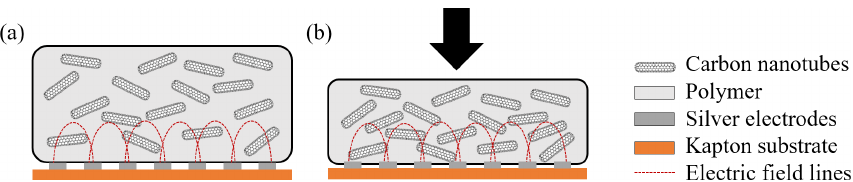
Figure 4. Illustration of the working principle of the MWCNT–PDMS pressure sensor. (a) Position of MWCNTs in the polymer matrix, and electric field of the underlying electrodes under no pressure. (b) With applied pressure, the MWCNTs are pushed close together and deeper into the electric